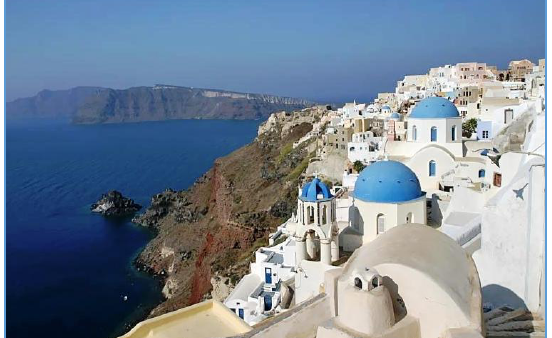
Figure 2. ‘Santorini’in Greece.